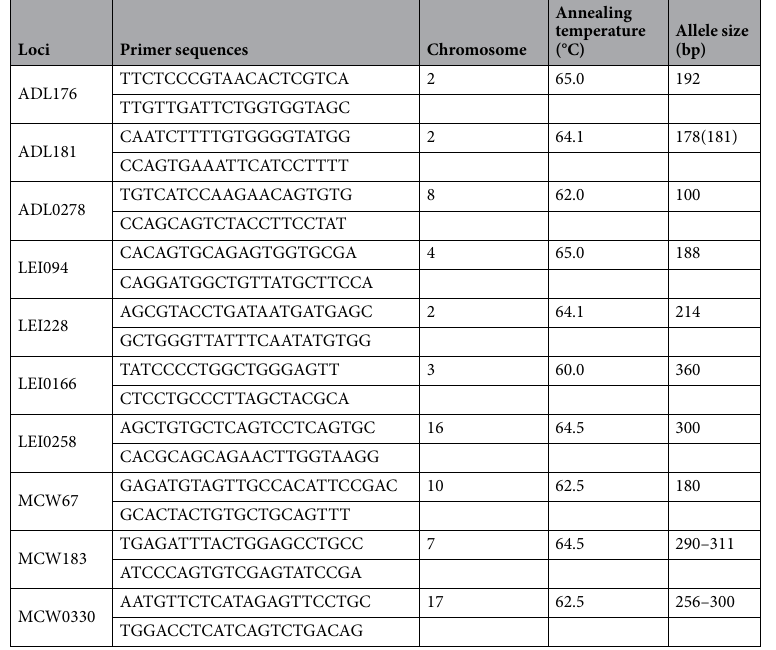
Table 3. Primers, PCR conditions, and allele sizes of each